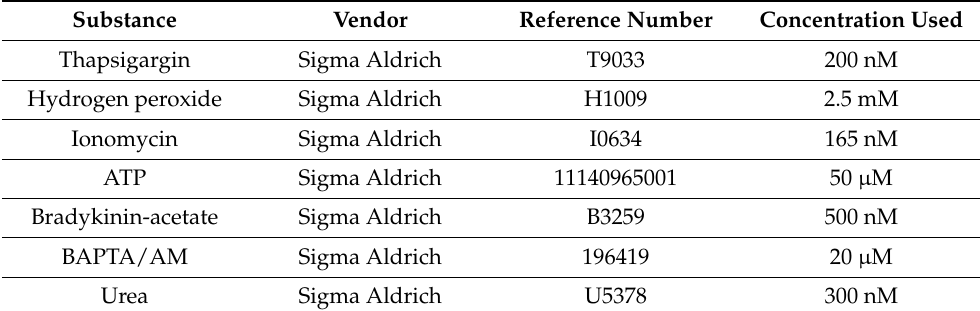
Table 4. Drugs used in this